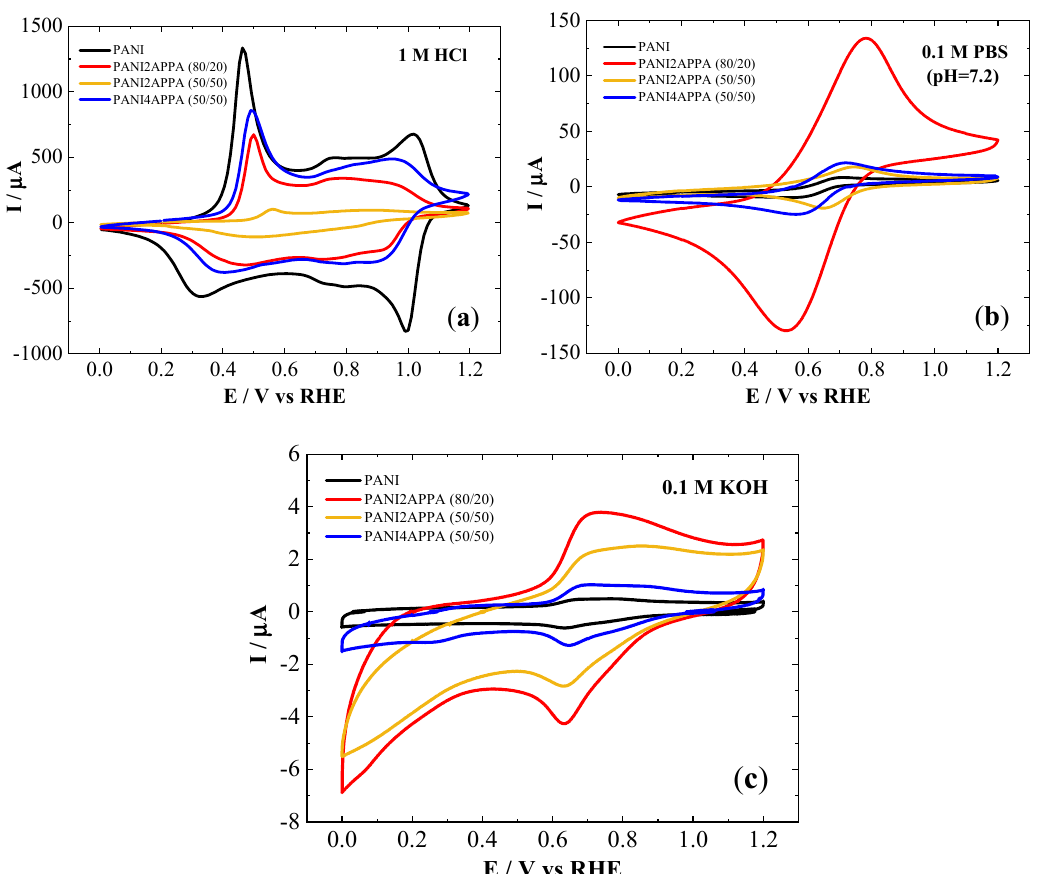
Figure 3. Cyclic voltammograms of Glassy Carbon (GC) electrodes modified with PANI (black line), PANI2APPA feed ratio 80/20 (red line) and 50/50 (orange line), and PANI4APPA feed ratio 50/50 (blue line) in: ( a ) Acid (1 M HCl), ( b ) neutral (0.1 M PBS, pH = 7.2), and ( c ) alkaline (0.1 M KOH) aqueous solution at 50 mV s − 1 under N 2 atmosphere.